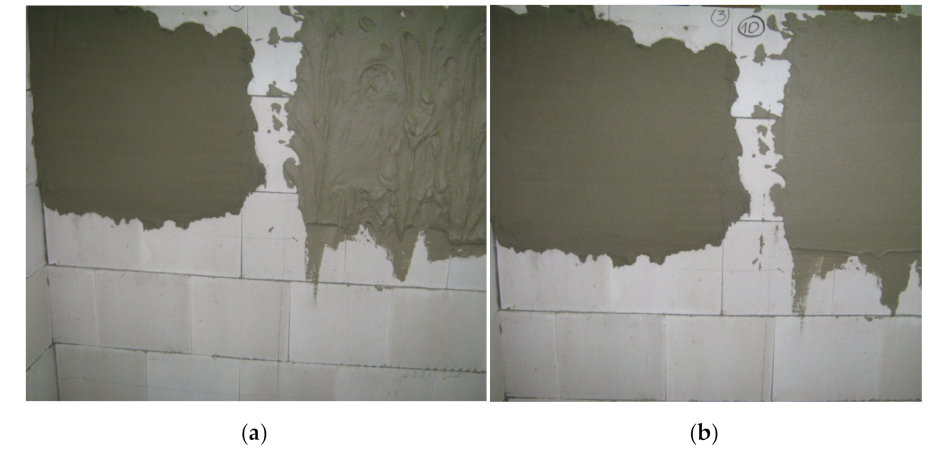
Figure 10. Images of walls ( a ) during application, and ( b ) during